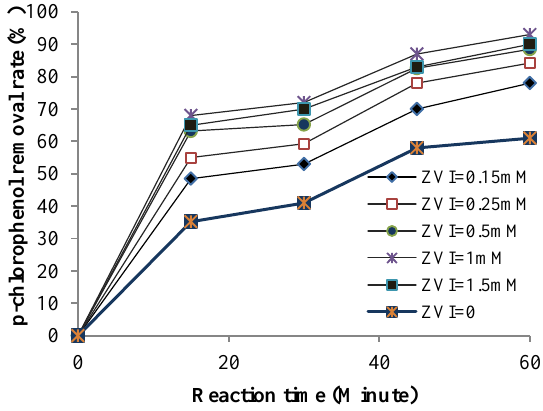
Figure 2. Influence of initial pH on the degradation of p-chlorophenol Initial experiments conditions: zerovalent iron = 0.5 mM, persulfate = 2 mM, p-chlorophenol = 0.44 mM